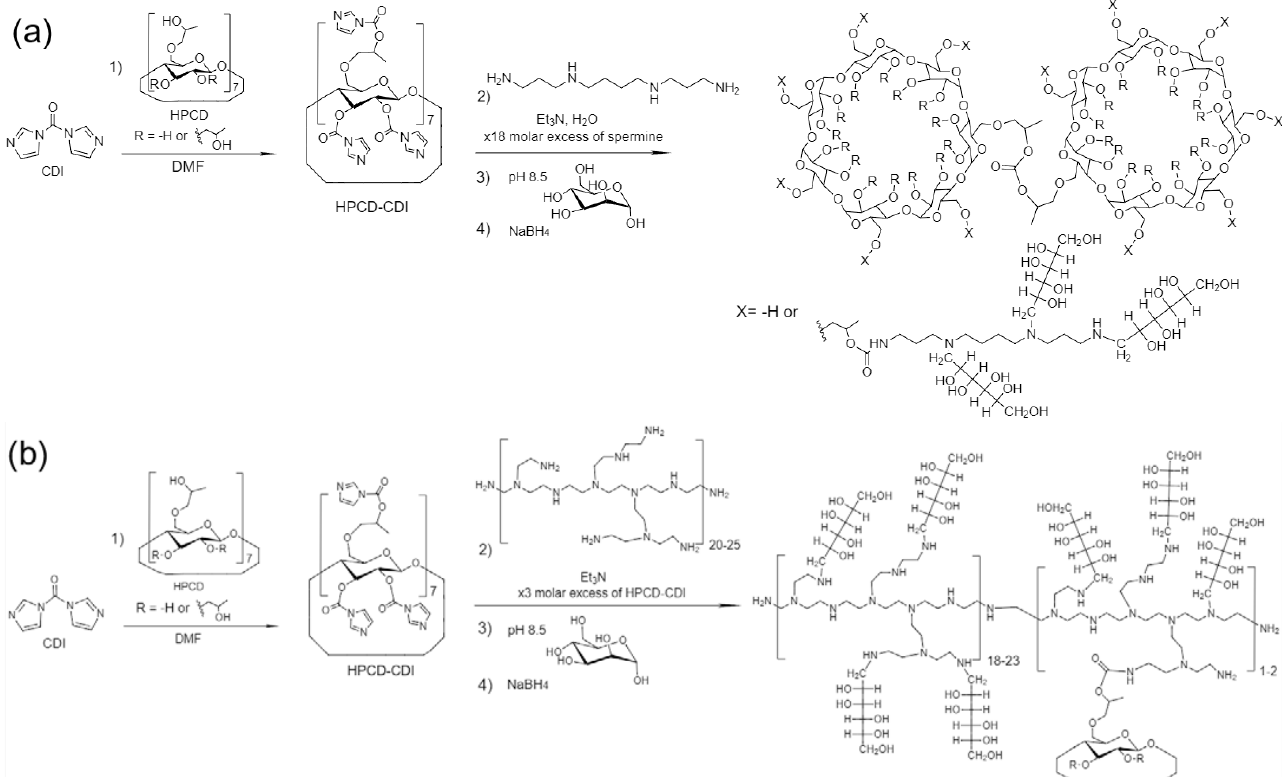
Figure 1. ( a ) The scheme of synthesis of mannosylated star-shaped HPCD-spermine-Man- 7 conjugate. The characteristics of the synthesized ligand are given in Table 1. The number of substituents X, not hydrogen atoms, is on average 9. ( b ) The scheme of synthesis of mannosylated HPCD-PEI10- Man- 9 conjugate. The characteristics of the synthesized ligand are given in Table 1. On average, one branched mannosylated chain of PEI accounts for 1–2 cyclodextrins. Table 1. Physical-chemical properties of obtained β -cyclodextrin conjugates.